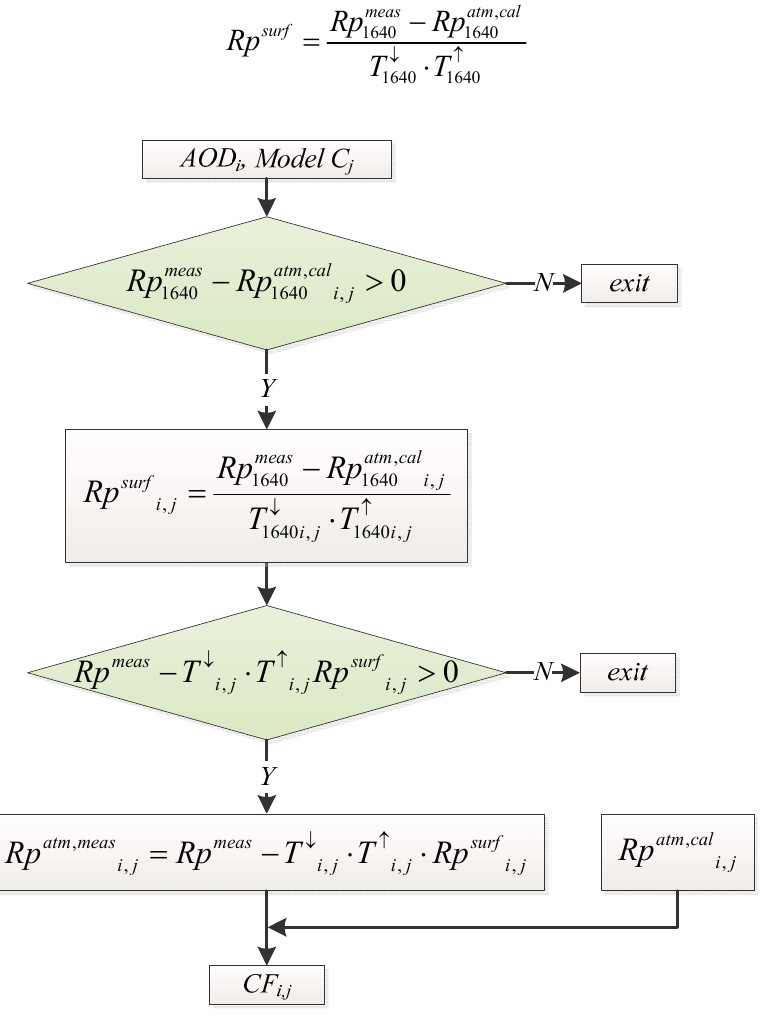
Figure 2. Flowchart for calculation of the cost function CF ( i and j denote the aerosol models and AOD nodes in LUT,